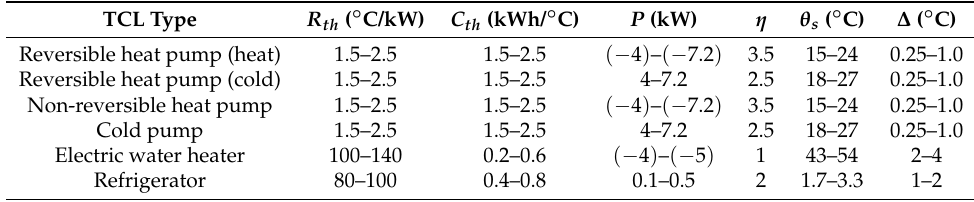
Table 3. Range of values for the parameters of residential